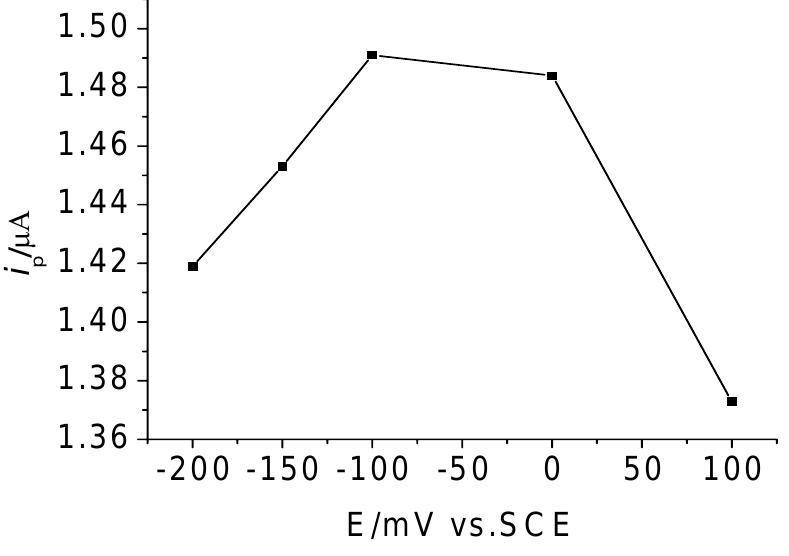
Figure 2. Effect of applied potential on the biosensor response studied by amperometric measurement O in 10.0 mL 0.02 M pH 7.0 PBS. for 9.68 × 10 -5 M H 2 2